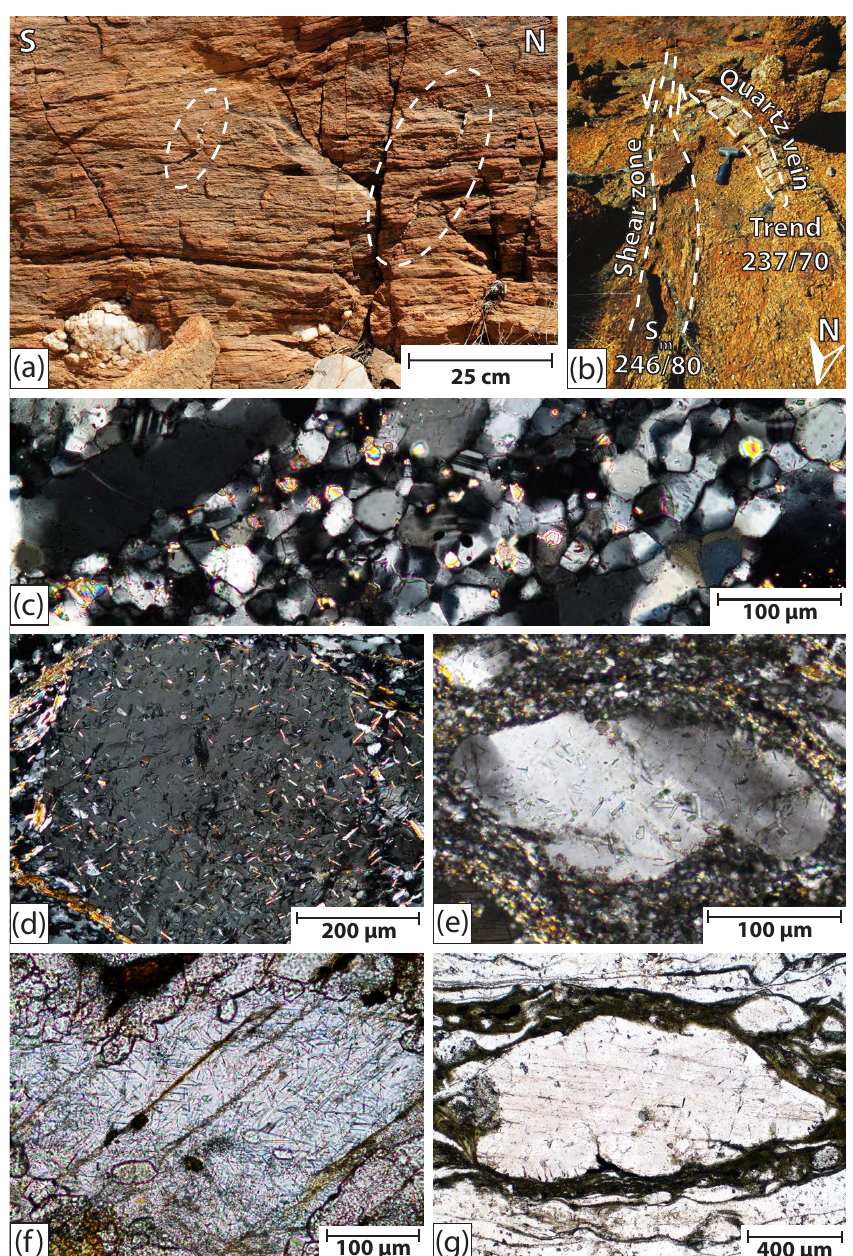
Figure 7. Field and thin-section images providing evidence for the presence or absence of fluids during deformation. (a) Quartz veins (encircled) crosscut the mylonitic foliation of the Woodroffe Thrust showing a sigmoidal shape consistent with rotation during overall top-to-north shearing. The quartz vein at the bottom of the picture is boudinaged and did not localize deformation. Outcrop NW15-264 (coordinates: 131.46883, − 25.83040; location 1 in Fig. 1). (b) Quartz vein adjacent to a sinistral shear zone that is not reactivated, even though shear zone and quartz vein are almost parallel to each other. Abbreviation: S m – mylonitic foliation. Outcrop SW13-200 (coordinates: 131.73810, − 25.99564; location 9 in Fig. 1). (c) Finely dispersed calcite (high birefringence) between newly formed feldspar grains under crossed polarized light. Thin section is not oriented. Sample NW14-423A (coordinates: 131.84368, − 26.11423; location 10 in Fig. 1). (d) Plagioclase clast with muscovite (higher birefringence) and epidote (lower birefringence) inclusions under crossed polarized light. Thin section is oriented N–S (left–right). Sample SW14-214A (coordinates: 131.44416, − 25.90284; location 5 in Fig. 1). (e) Plagioclase clast with epidote inclusions under crossed polarized light. Thin section is oriented N–S (left–right). Sample GW13-415 (coordinates: 131.66256, − 25.99928; location 8 in Fig. 1). (f) Plagioclase clast with kyanite inclusions (greenish needles) and neo-crystallized garnet under plane- polarized light. Thin section is not oriented. Sample SW13-167 (coordinates: 131.77475, − 26.30845; location 14 in Fig. 1). (g) Inclusion-free plagioclase clast under plane-polarized light. Thin section is oriented NNE–SSW (left–right). Sample SW13-318 (coordinates: 132.14311, − 25.99142; location 6 in Fig.